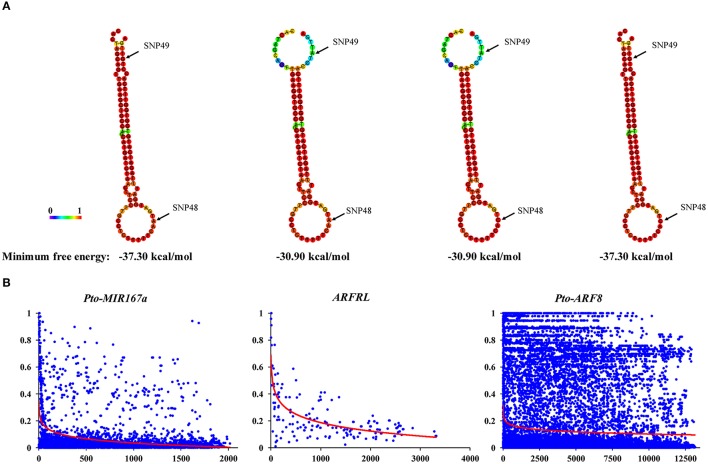
Secondary structures of the pre-miRNA region of Pto-MIR167a with single nucleotide polymorphisms (SNPs), and linkage disequilibrium within Pto-MIR167a, lncRNA gene ARFRL, and Pto-ARF8. (A) The secondary structures of Pto-MIR167a pre-miRNA sequence affected by two SNPs in the pre-miRNA region, and the minimum free energy of these secondary structures. (B) Pairwise correlations between SNPs (r2) are plotted against the physical distance between each SNP pair. The red curves indicate the nonlinear regressions of r2 on the physical distance in base pairs.